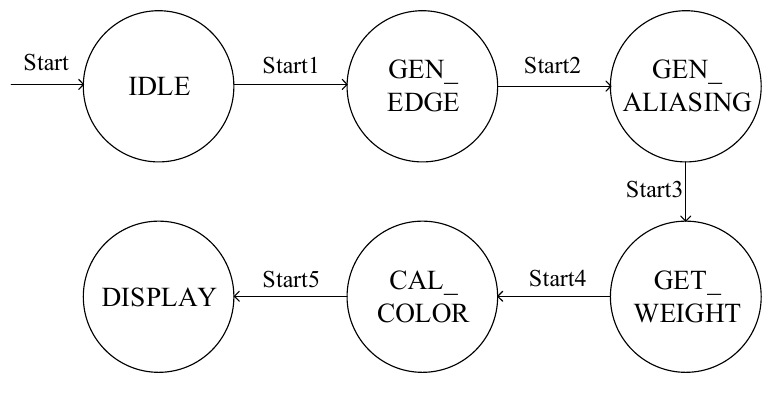
Figure 7. State machine on the top level.